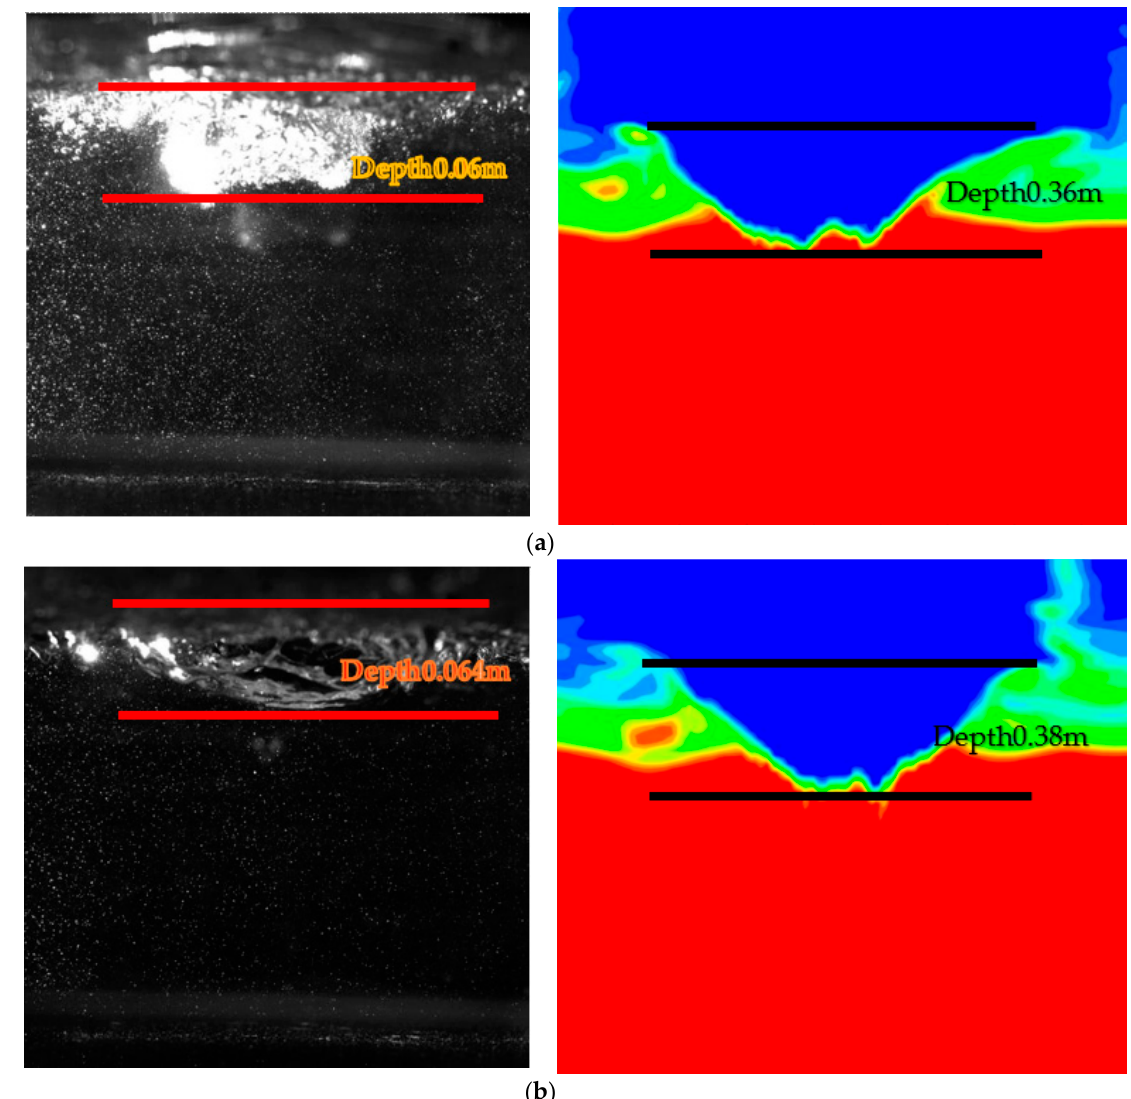
Figure 2. Schematic diagram of experimental equipment.